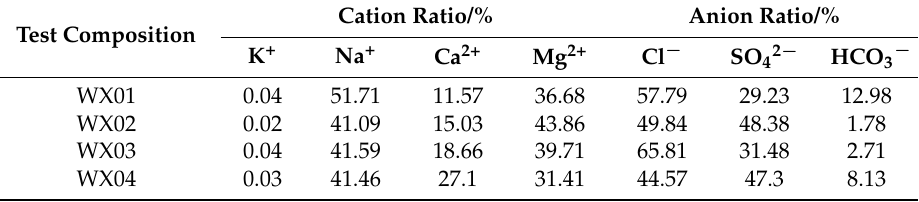
Table 3. Milliequivalent percentage statistics for the experimental water chemical composition ( n =